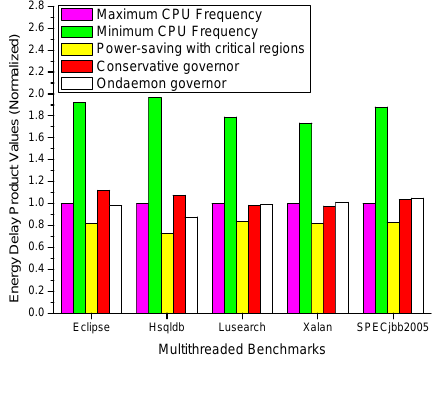
Figure 9. The EDP values of power-saving